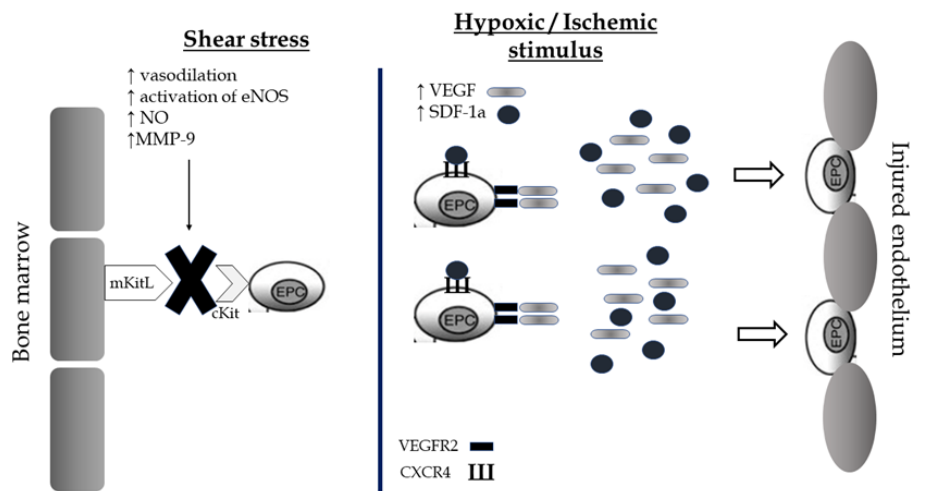
Figure 3. Shear stress and hypoxic/ischemic stimulus as potential mechanisms of mobilization of Endothelial Progenitor cells from the bone marrow and restoration of the endothelial barrier after exercise. EPCs, endothelial progenitor cells; NOS, nitric oxide synthase; NO, nitric oxide; VEGF, vascular endothelial growth factor; SDF, Stromal cell-derived factor; VEGFR, vascular endothelial growth factor receptor; CXCR, C-X-C chemokine receptor.